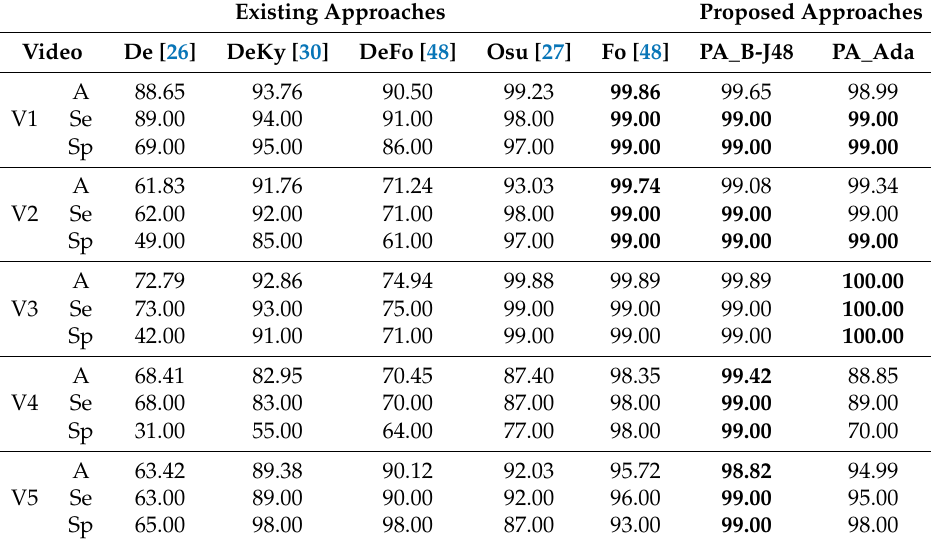
Table 3. Experiment 2: Comparison of the existing approaches, De, DeKy, DeFo, Osu, Ky, and Fo, with the proposed approaches, ‘PA_B-J48’ and ‘PA_Ada’, in terms of % accuracy (A), % sensitivity (Se) and % specificity (Sp) for each Video (V) of the MCF dataset with 10-fold cross validation using two categories: ‘Fall’ and ‘No Fall’. Maximum value in each row is shown in